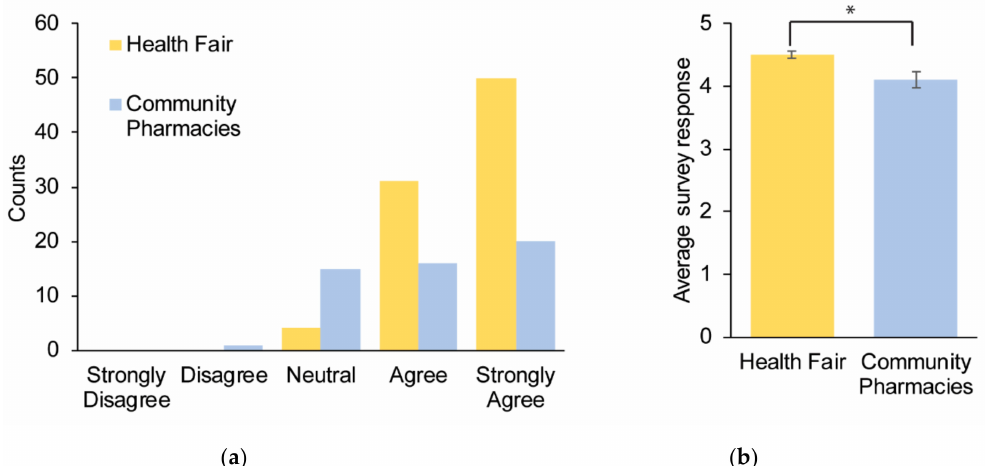
Figure 4. Survey responses to the question: “I believe pharmacogenomics testing is valuable”. A total of 137 participants provided responses across multiple sites and were subsequently categorized as the symposium ( n = 85) and community pharmacy ( n = 52) participants. ( a ) Cumulative responses for each category depicted by di ff erent colors for the two cohorts. ( b ) The average survey response for the two cohorts. Error bars = SEM.